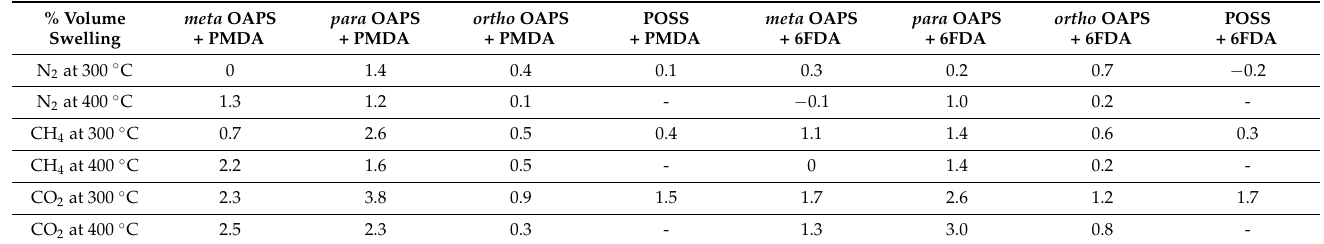
Table 4. Average percent of volume swelling upon sorption of N 2 , CH 4 and CO 2 penetrants in the polyOAPS/POSS-imides networks at both 300 °C and 400 °C and at 60 bar. The maximum standard error is 0.3%.